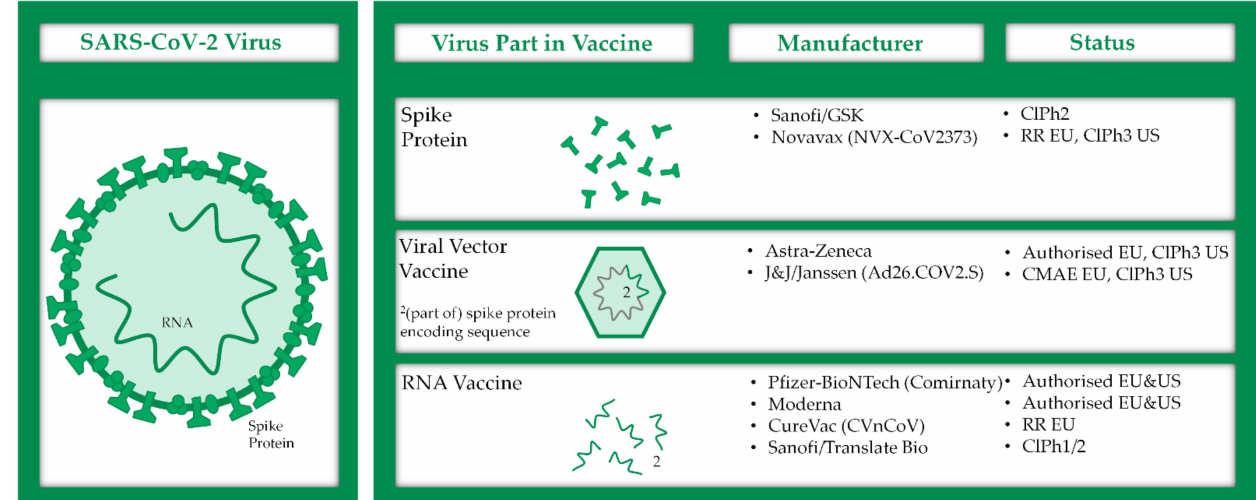
Figure 2. Examples of vaccine candidates, manufacturers, technologies and trial phases. Three major subtypes can be distinguished: drugs that already contain the immune response-inducing spike protein; viral vectors, mostly AAV, that deliver the spike protein-encoding DNA sequence into the cells; and the mRNA drugs discussed in this paper, which carry the gene information of the spike protein in the form of the mRNA for direct spike-protein formation in the patient’s cells and are delivered in LNP [29].